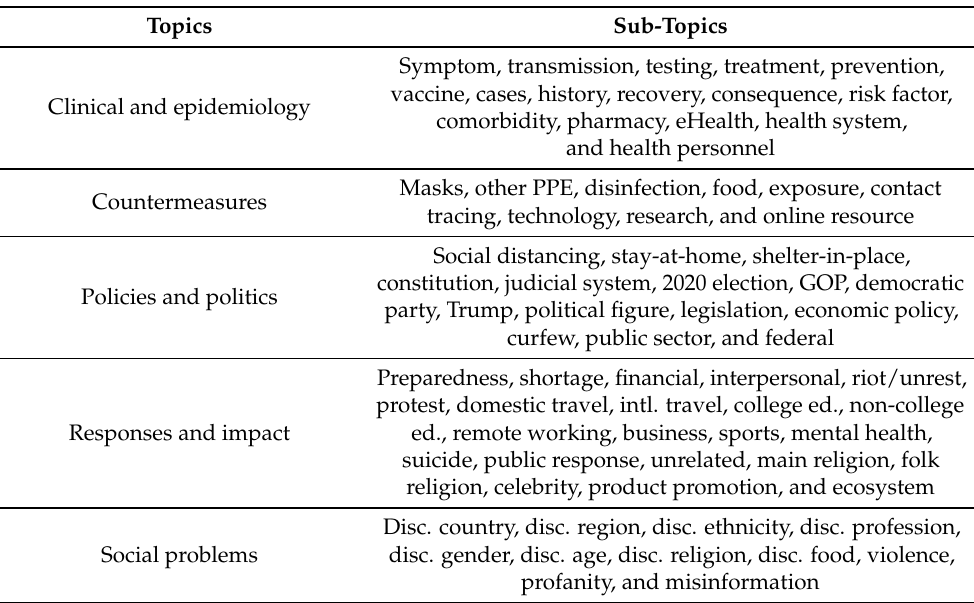
Table 2. Topics and sub-topics of COVID annotating